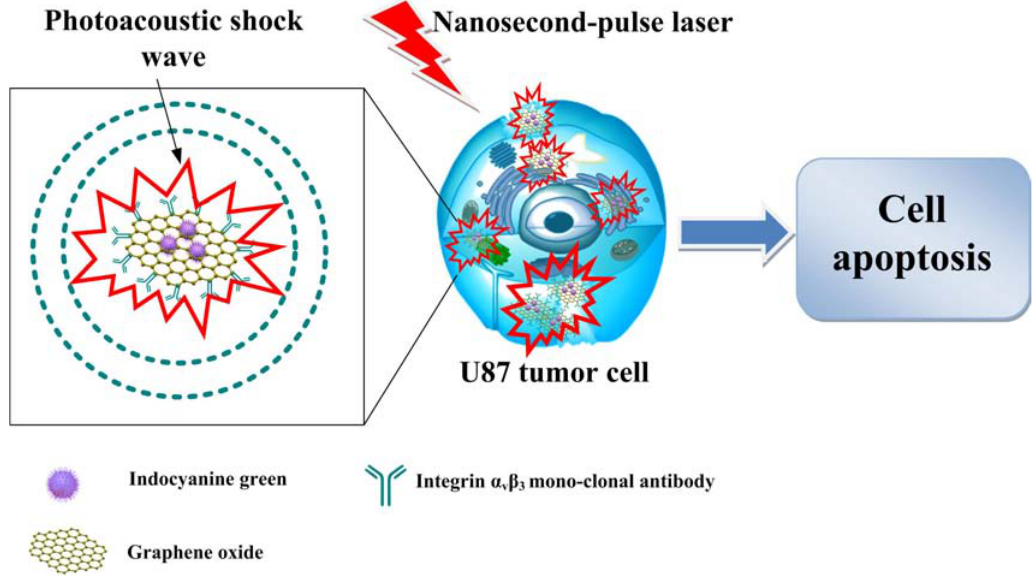
Fig. 1. The schematic diagram of photoacoustic therapy with the assistance of GO-ICG. Under pulsed laser irradiation, a strong shock wave generates from GO-ICG based on photoacoustic e®ect. Then, the strong shock wave could destroy the cell membrane, resulting in cell